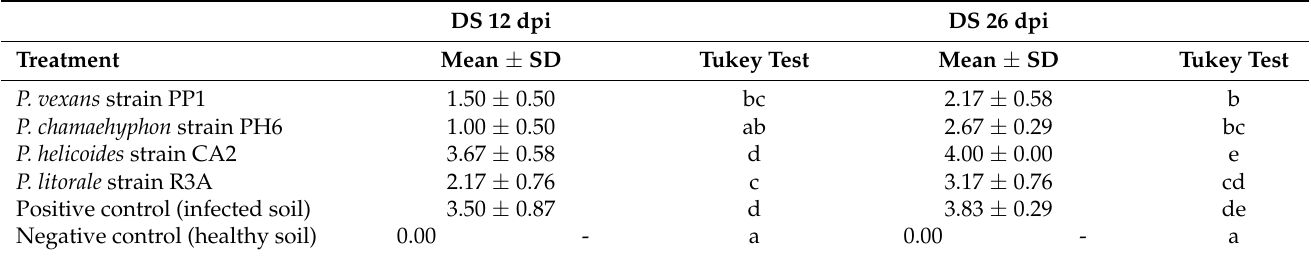
Table 2. Results of disease severity (DS) on 1-year-old plants of A. chinensis var. deliciosa ‘Hayward’ plants at 12 and 26 dpi. Values in the same column followed by the same letter are not statistically different by Tukey test ( p ≤ 0.05). DS 12 dpi DS 26 dpi